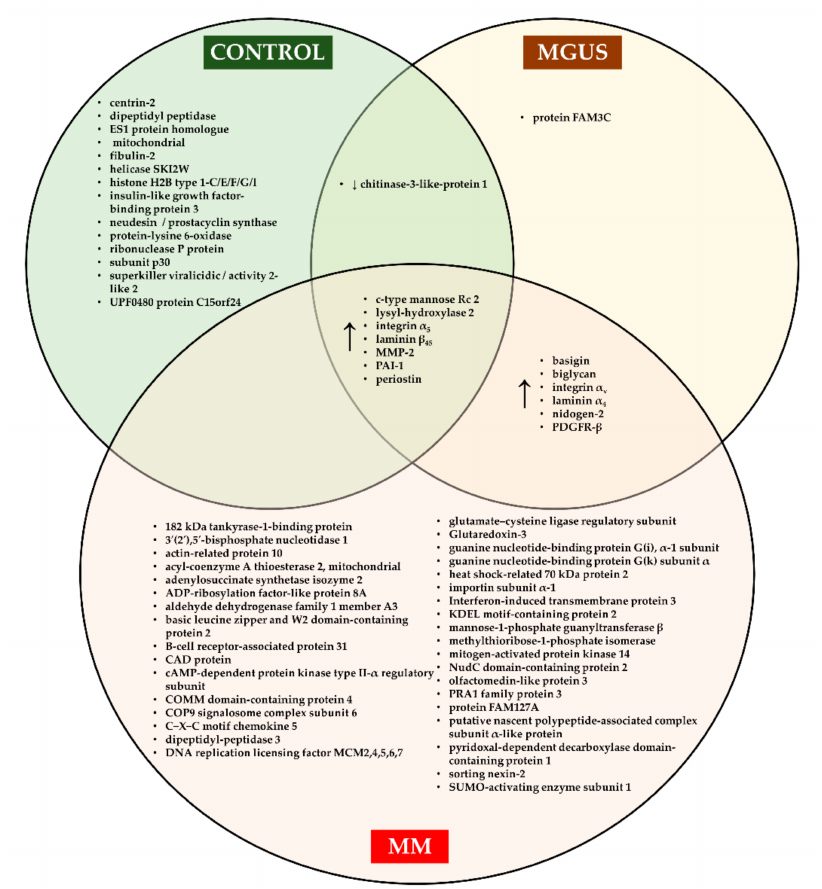
Figure 4. Extracellular matrix proteins that are expressed at different phases of multiple myeloma. ECM proteins are synthesized by BM stromal cells, which are nonhematopoietic,